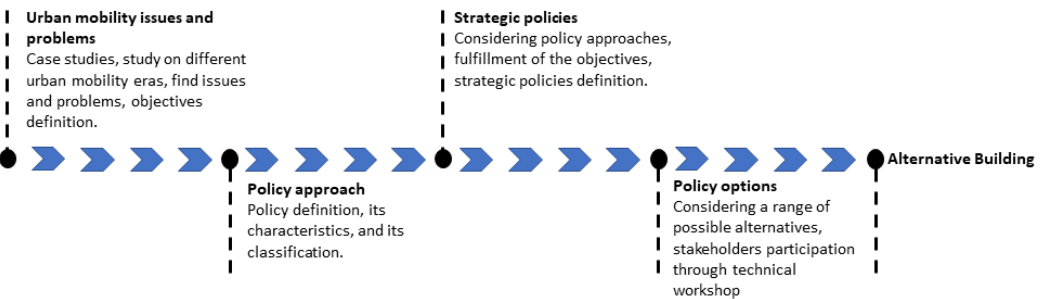
Figure 7: The process of determining alternatives to improve urban mobility in the Tehran